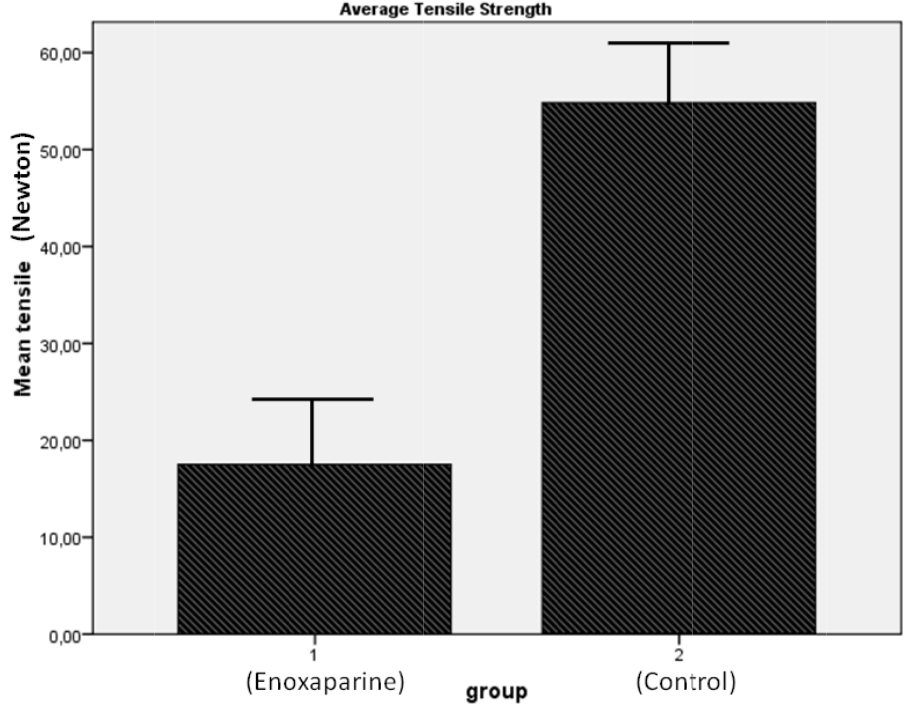
FIGURE 1 - Average tensile strength tests (Newton) from rats treated with enoxaparin group (1) and saline group (2) were analyzed by t -test